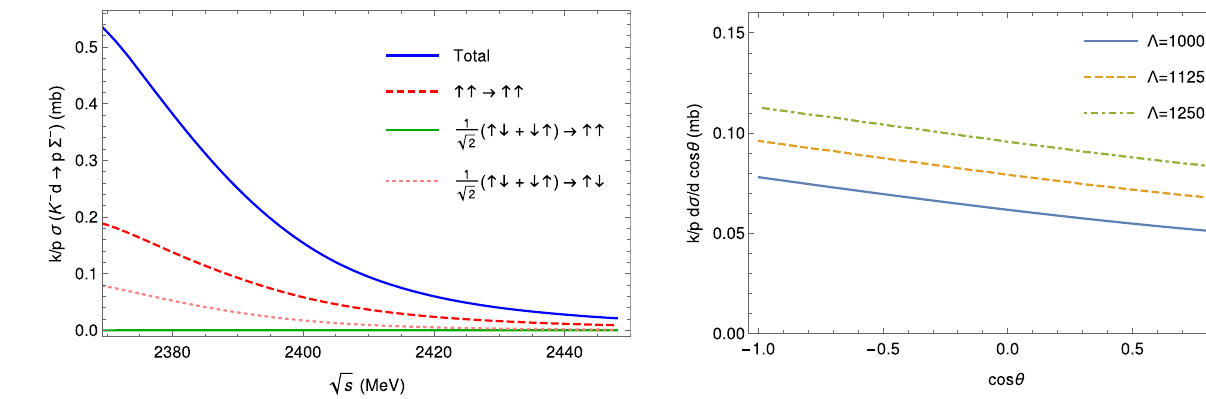
d σ of the K − d → p Σ − reaction √ √ p d cos θ s = s th + 10 MeV (left)